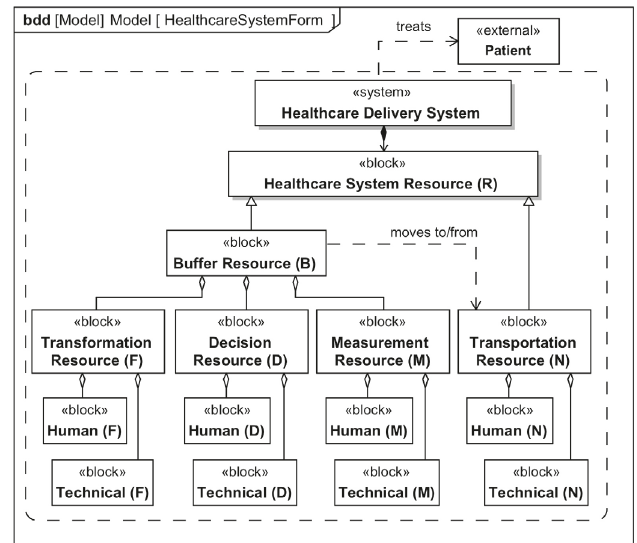
Figure 2: SysML block diagram of healthcare system